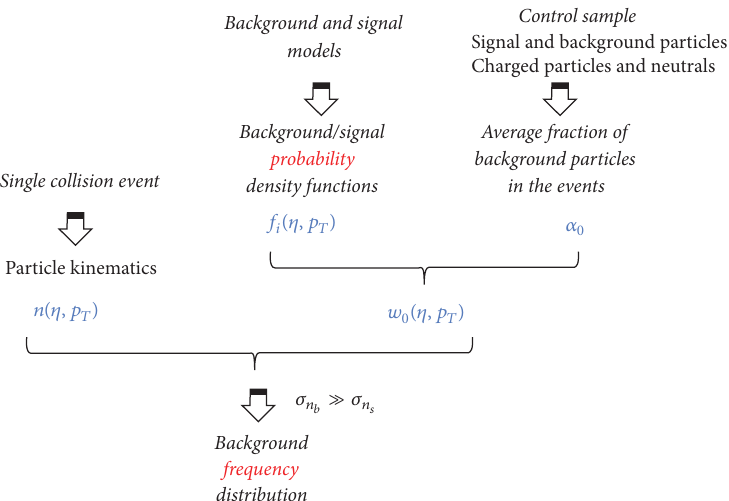
Figure 2: Overview of the method proposed in this article. Information from the background and signal models, as well as from the data, is combined into an estimate of the number of soft QCD particles across the particle ( 𝜂,𝑝 𝑇 ) space inside each collision event, ̂𝑛 𝑏 (𝜂, 𝑝 𝑇 ) , under the assumption that the statistical fluctuations in the data are dominated by the fluctuations on the number of soft QCD particles. The background and signal PDFs are denoted by 𝑓 0 and 𝑓 1 , respectively.